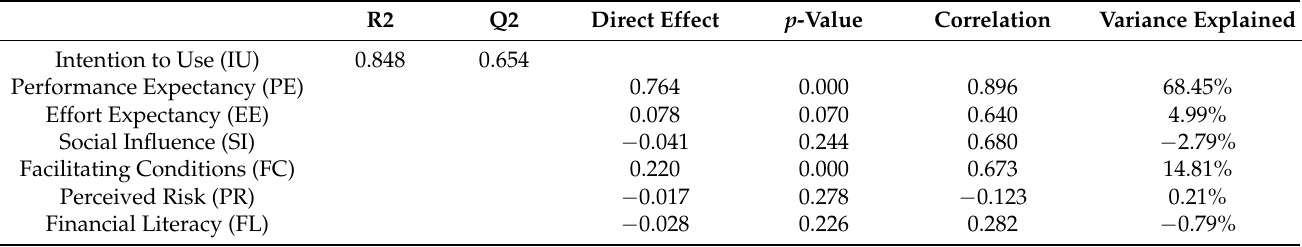
Table A5. PLS estimates in [7] for the hypothesis in Section